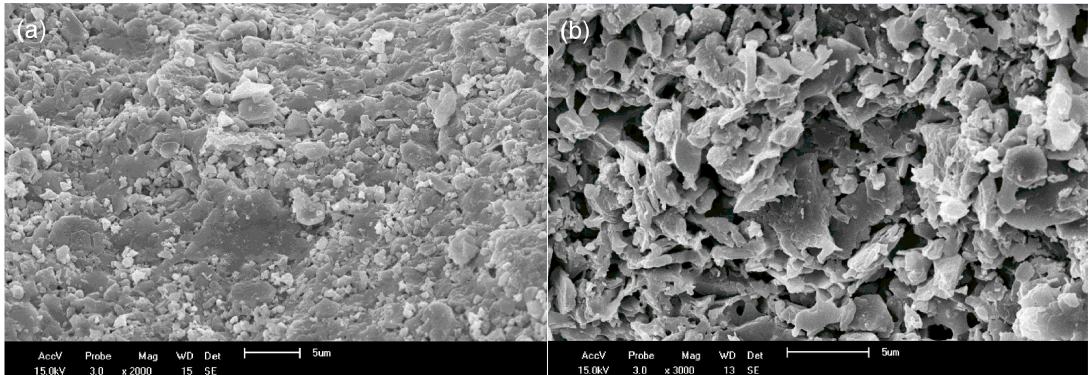
Figure 2. Scanning electron microscopy (SEM) of the tubular ceramic membrane (a) surface and (b) cross